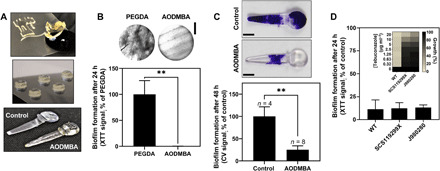
Resistance of AODMBA to C. albicans biofilm formation on 3D-printed polymer forms and in drug-resistant isolates.(A) AODMBA polymer 3D-printed into different forms including 3-mm-diameter coupons and 1.9-cm-length voice prosthesis valve flap (bottom). Photo credit: Yinfeng He, University of Nottingham. (B) Biofilm formation on the coupons (assayed as in Fig. 2A). PEG575DA (PEGDA) served as attachment positive control. Values are means ± SEM (n = 3). **P ≤ 0.01, unpaired t test. Microscopic images were taken just before XTT assay. Scale bar, 1.20 mm. (C) C. albicans biofilm, stained with crystal violet (CV), on valve flap samples 48 hours after inoculation. Biofilm that was evident with some AODMBA valve flaps detached when the form was moved or gently rinsed, unlike biofilms on commercial silicone–manufactured flaps (control). **P ≤ 0.01, unpaired t test. Images are representative of three or more independent attachment assays. Scale bars, 0.37 cm. Photo credit: Cindy Vallieres, University of Nottingham. (D) Percentage attachment to AODMBA by C. albicans CAF2-yCherry (WT) and azole-resistant isolates, C. albicans SCS119299X and J980280, relative to uncoated microplate wells. Values are means ± SEM from three independent experiments. There was no significant difference between strains according to Dunnett’s multiple comparisons by two-way ANOVA. Inset: Azole resistances of the strains.